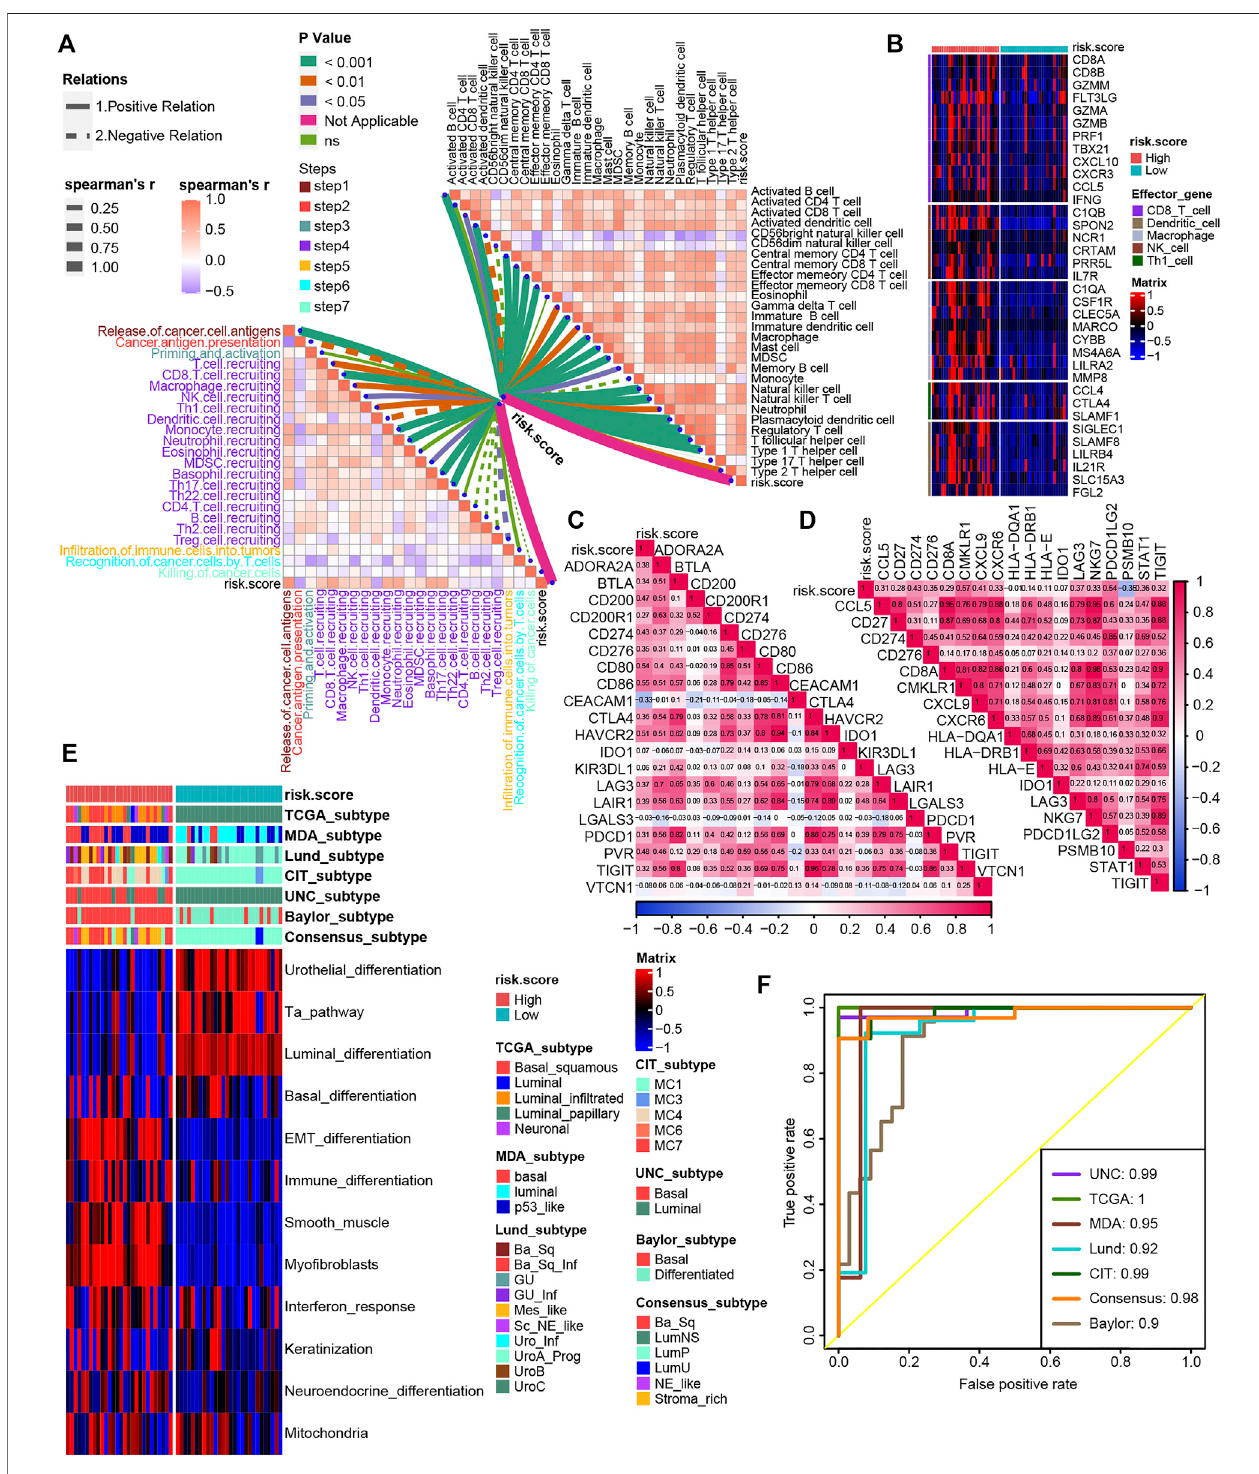
FIGURE 6 | Validation of the TNF family – based risk score roles in the Xiangya cohort. (A) The association between TNF-based risk score, cancer-immunity cycles (left) , and immune cells in the TME (right) in the Xiangya cohort. The different types of lines represent the positive or negative relations. The different colors of the lines represent the p values of the relations, and the thickness of the lines represents the strength of the relations. (B) The different expression patterns of effector genes of immune cells between different TNF-based risk score groups in the Xiangya cohort. (C , D) The association between TNF-based risk score and ICI genes and TIS genes, respectively, in the Xiangya cohort. (E) The heat map of different TNF-based risk score groups, seven molecular subtype classi fi cations, and bladder cancer – associated signatures in Xiangya cohort. Activated or inhibited pathways are marked as red or blue, respectively. (F) AUC plot of the risk score for predicting seven molecular subtype classi fi cations in the Xiangya